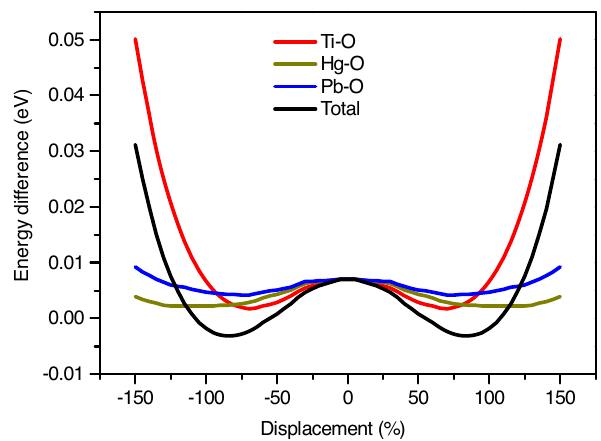
Fig. 6 First principles calculation results of the energy changes with respect to the different moving mode along one of the soft mode on Γ point. The red, yellow, blue lines correspond to Ti-O displacements only, Hg-O displacements only and Pb-O displacements only. The black line corresponds to all atoms displacements. The double well structure of the graph indicates the spontaneous structure phase